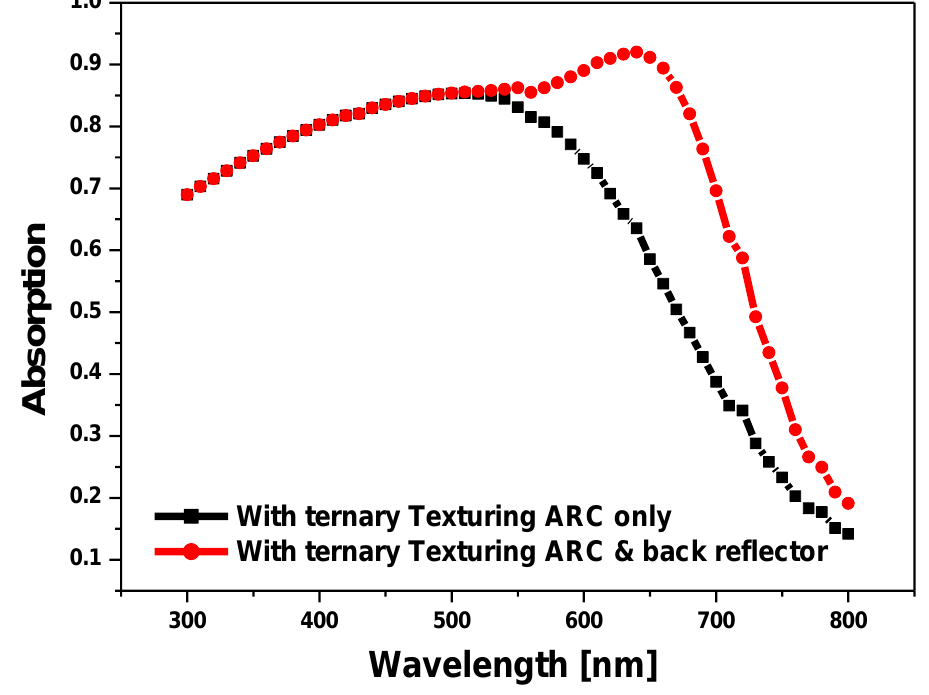
Figure 7. Hydrogenated amorphous silicon solar cell (a-Si: H) absorption spectrum with ternary anti-reflective coating with texturing on the top surface with a height equal to 50 nm. The ternary ARC is composed of silicon nitride with a thickness of 33 nm immersed between silicon dioxide and titanium dioxide with a thickness of 54 nm and 82 nm, respectively. Also, the back reflector is composed of silicon dioxide and silicon, with thicknesses of 40 nm and 75 nm, respectively. The number of periods equals 12.